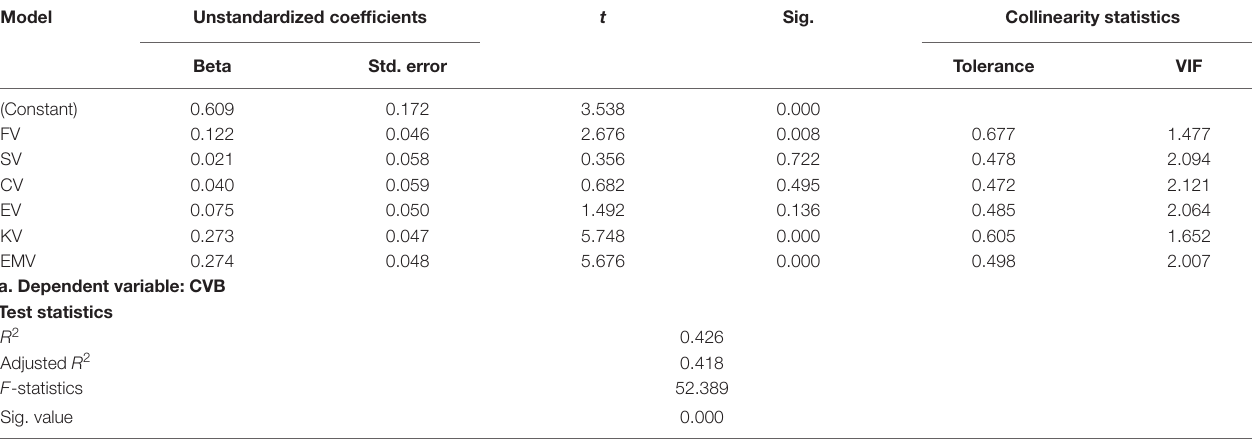
TABLE 9 | Regression results among the variables (Pakistan).